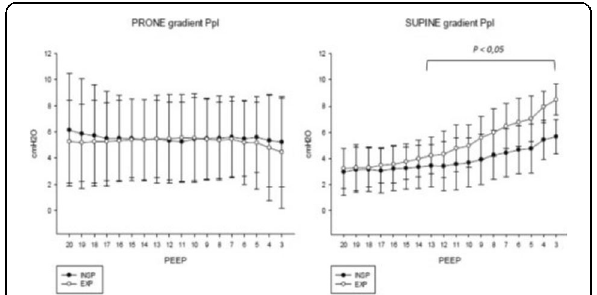
Fig. 1 (abstract 001055). Note: In SP interaction between PEEP and delta Ppl in both INSP and EXP (p < 0001), in PP no statistical interaction. Gradient Ppl =Ppl ventral -Ppl dorsal (in absolute value).